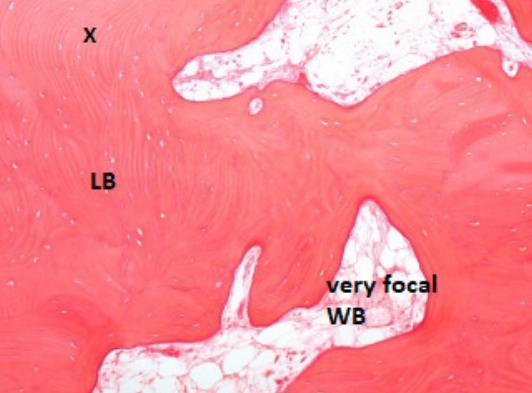
Figure 4. Patient ID: MA. Bone samples taken after 2 months of stabilization presented 10% woven bone (WB). LB: Lamellar bone. The small black cross indicates the apical portion of the sample. It was also observed that in the specimens, in which the osteoblast prevailed over the osteoclast, the median of the period of stability was 2